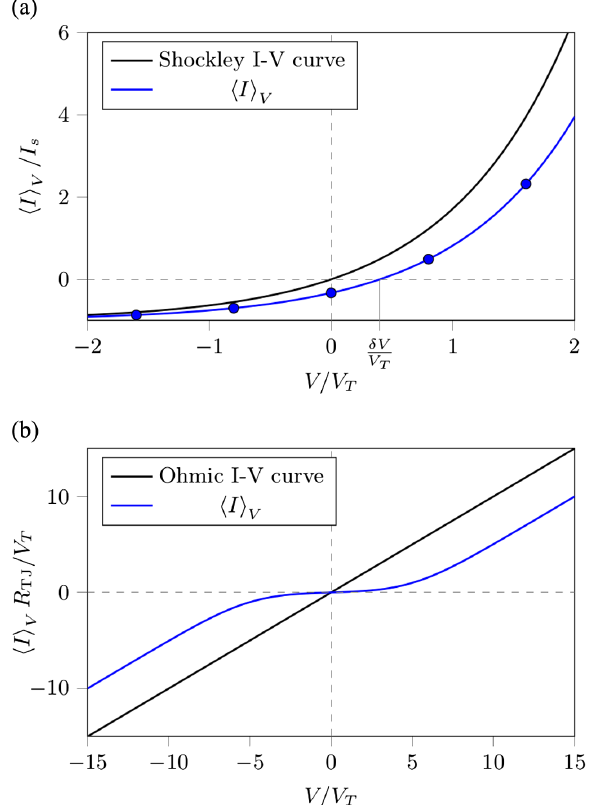
FIG. 6. Charging effects in the characteristic I - V curve of a 0 . 4 ) and (b) tunnel junction (a) Shockley diode ( δ V=V T ¼ 5 ( δ V=V T ¼